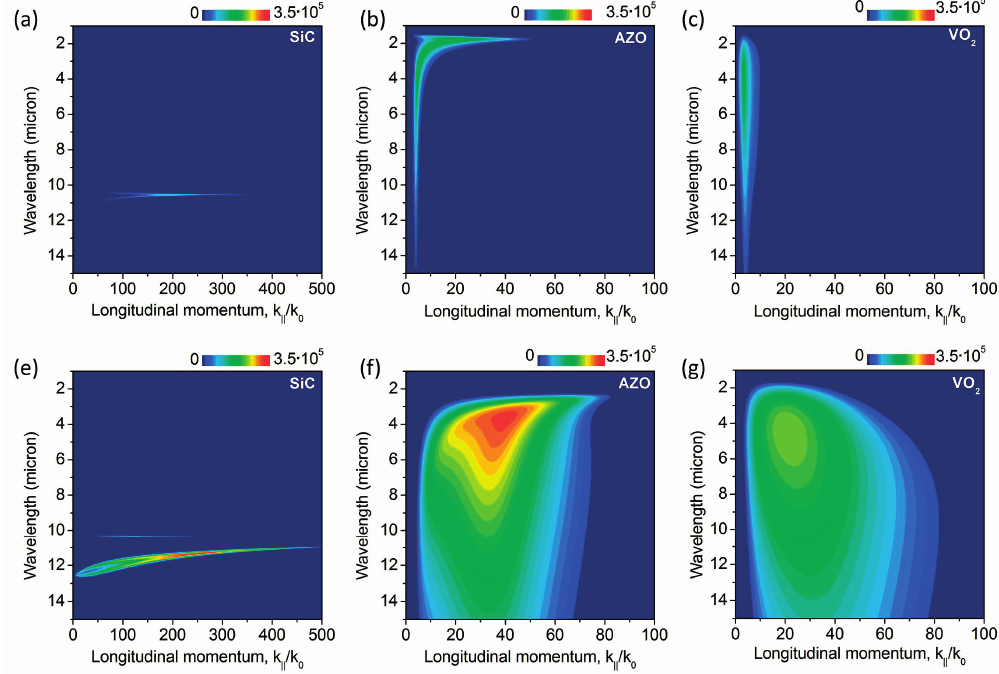
Figure 4. Wavevector-resolved transmission coefficients from Equation (2) for bulk ( a – c ) versus thin 2 nm-thin film ( e – g ) energy transfer for ( a,e ) SiC, ( b,f ) AZO, and ( c,g ) Vanadium dioxide (VO 2 ). The emitter and absorber are separated by a 20 nm gap, and the hot and cold side temperatures are 1000 K and 360 K,